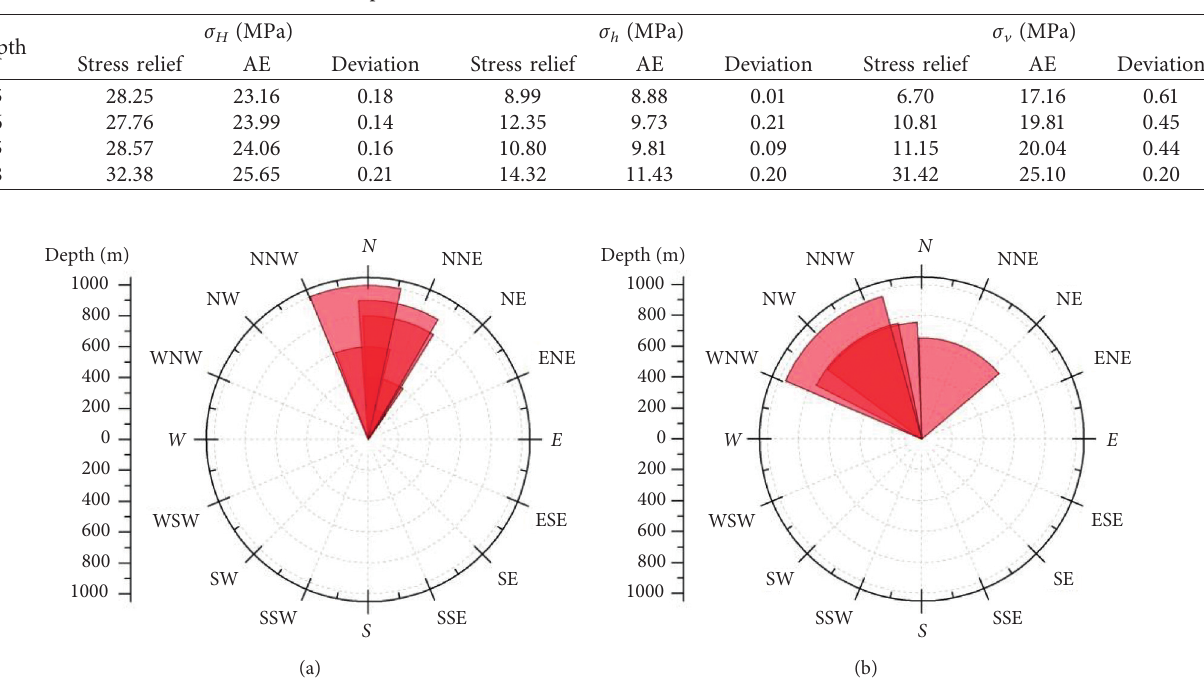
Table 4: Comparison of the results of stress relief method and AE method.